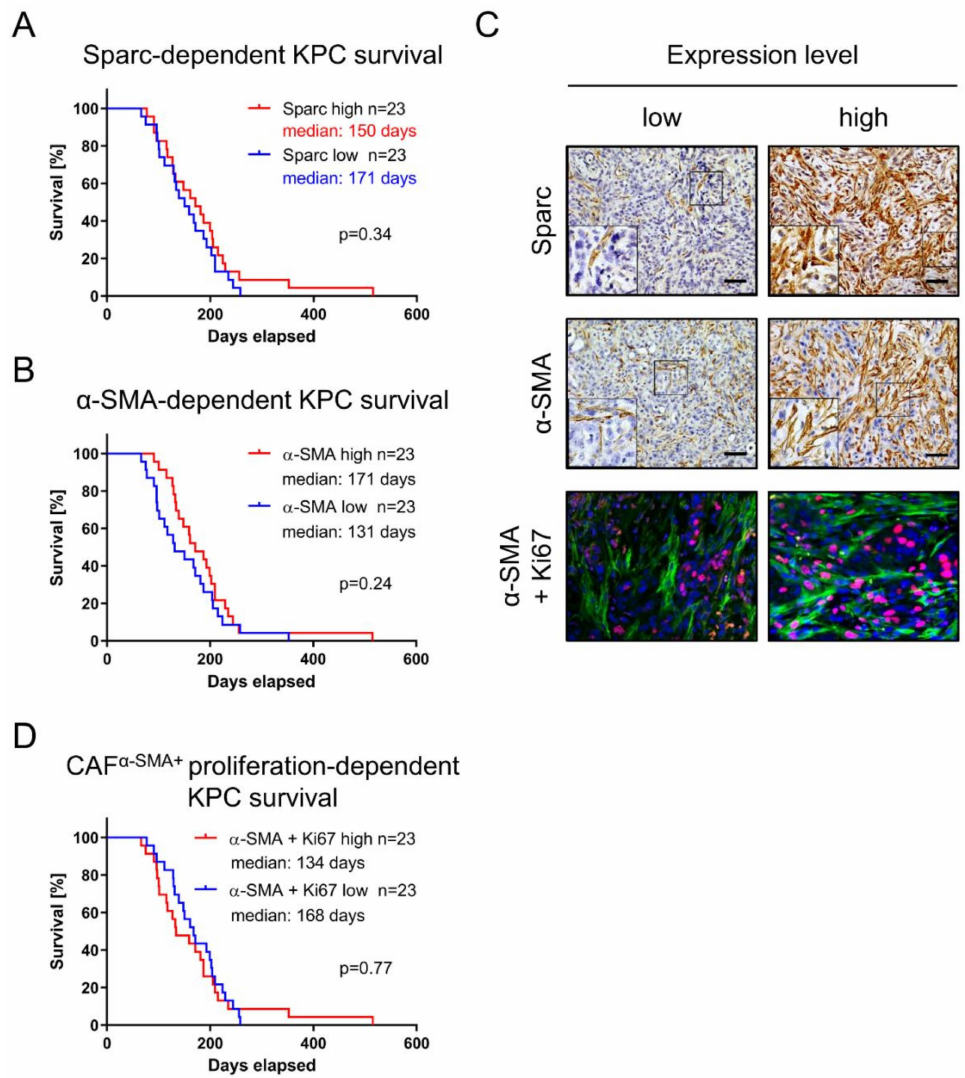
Figure 3. Fibroblast-dependent KPC survival. Fibroblast-specific markers ( A ) Sparc and ( B ) α -SMA were examined for their prognostic value in KPC model. ( C ) Quantification based on IHC or IF, respectively, dividing KPC cohort into low- and high-expressing tumors. Scale equals 50 µ m. ( D ) cancer-associated-fibroblast (CAF) proliferation assessed via IF, quantifying proportion of Ki67 and α -SMA double-positive cells in murine PDAC